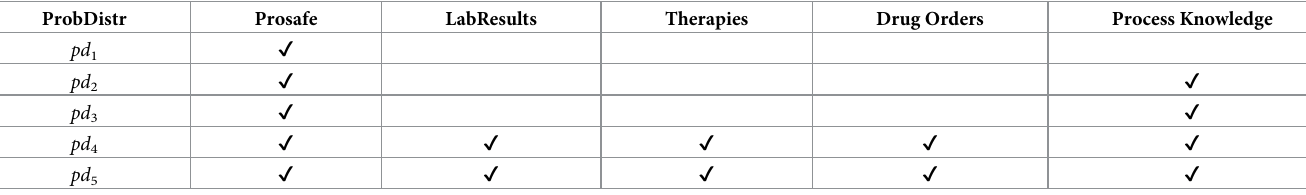
Table 7. Data source for each empirical probability